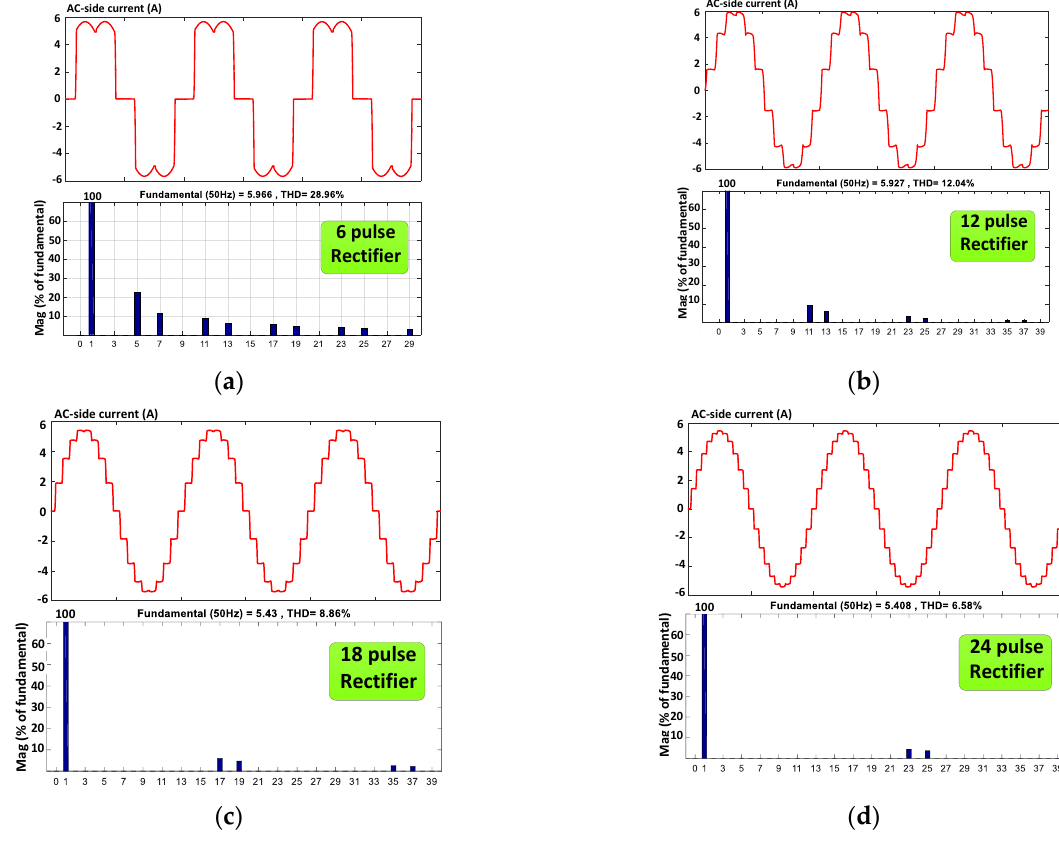
Figure 3. The primary-side current of n -pulse AC / DC converters with FFT analysis. ( a ) 6-pulse ( b ) 12-